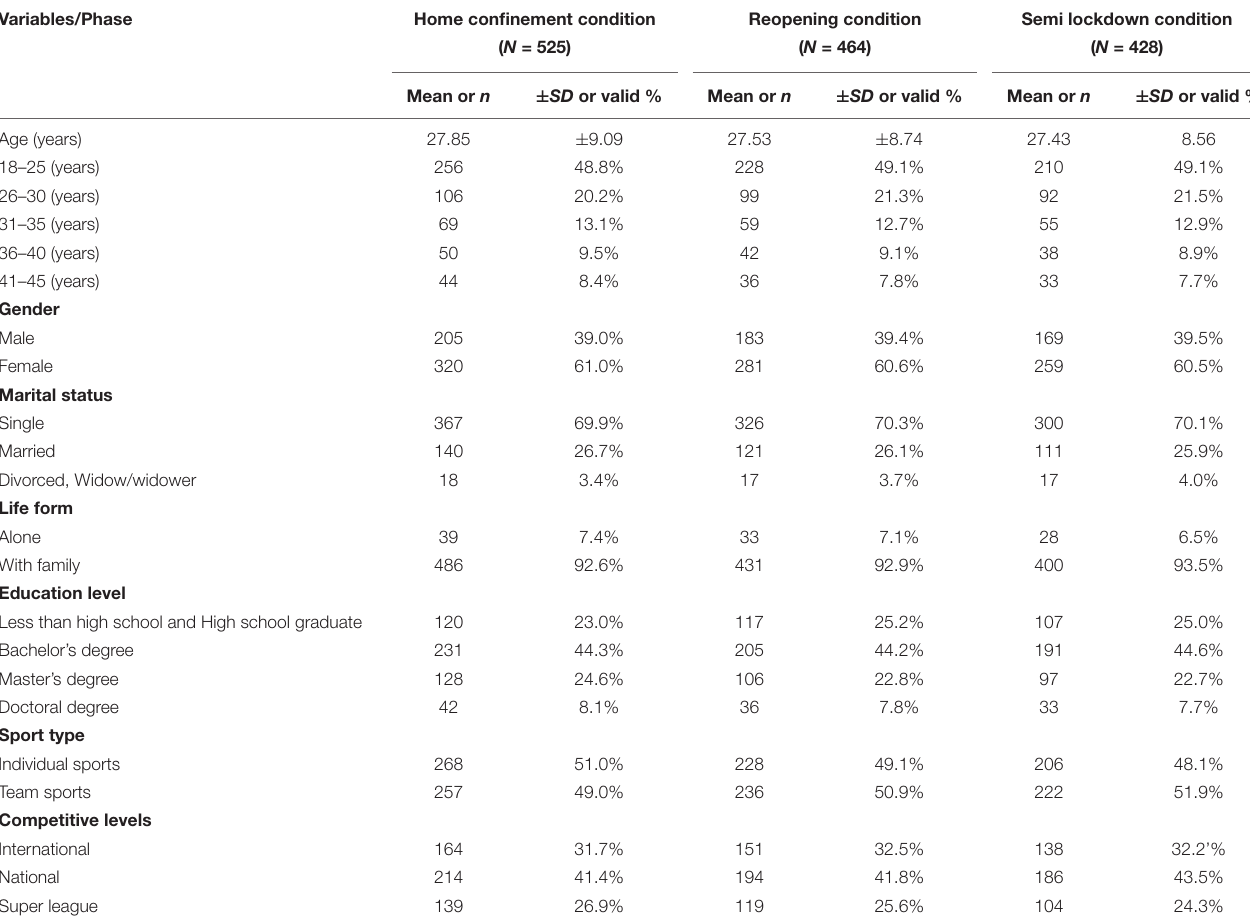
TABLE 1 | Participants’ demographic